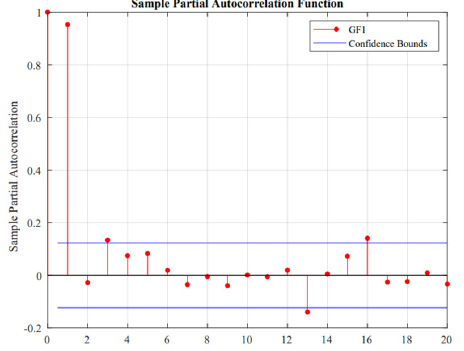
Fig. 11 . Autocorrelation Graph of Silver Price Data Fig. 12. Partial Autocorrelation Graph of Silver Price